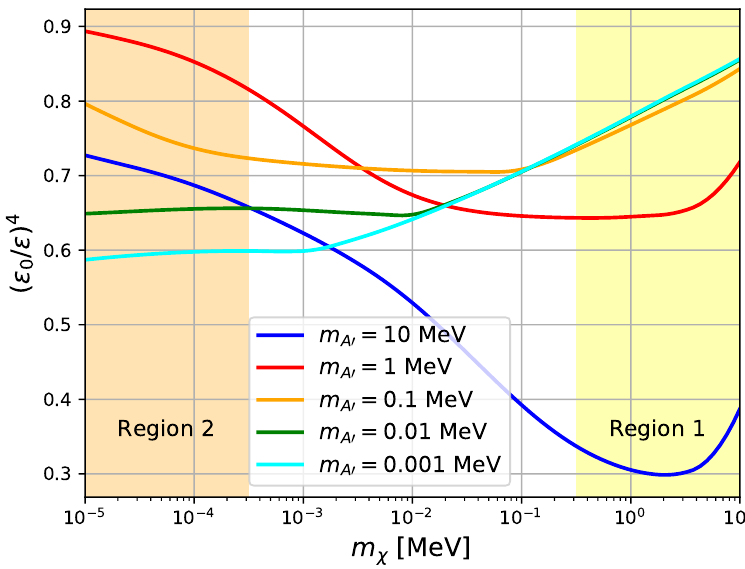
Figure 4 . The ratio between the exclusion limits of Super-K with (denoted by (cid:15) ) and without (denoted by (cid:15) 0 ) considering the PDF effects. The ratios for different dark photon masses are indicated by the line colors. The dark matter coupling g 0 = 1